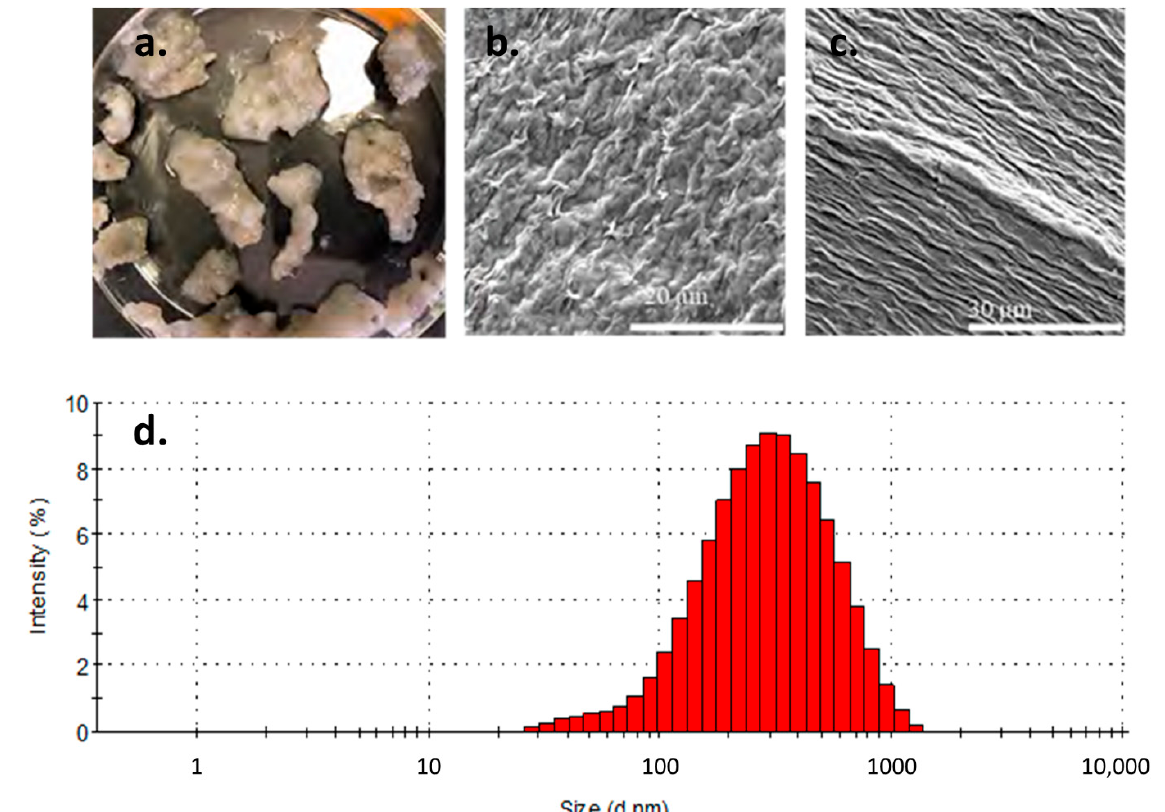
Figure 5. ( a ) Post ‐ reaction gel mixed with clay from IEBS ‐ 4. ( b ) SEM images of the dried gel with cross ‐ linked texture. ( c ) Dried gel with linear texture. ( d ) Distribution of colloid diameters (nm) from sample IEBS ‐ 5, dispersed in DI water and measured via Zetasizer.